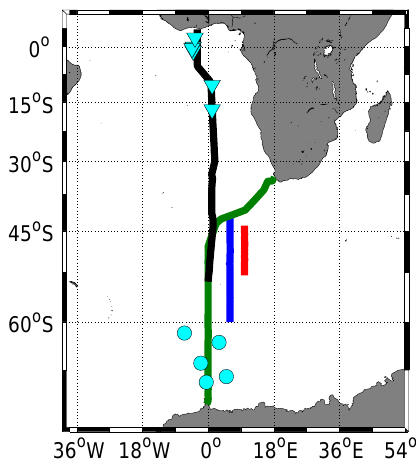
Figure 6. Sections of transient tracer surveys. The section of the ANT-XXVIII/3 cruise of 2012 is highlighted as a red line, the CLI- VAR A13.5 cruise of 2010 as a black line, the SWEDARP cruise of 1997/98 as a blue line, the ANT-X/4 cruise as a green line and the 39 Ar data as cyan dots and